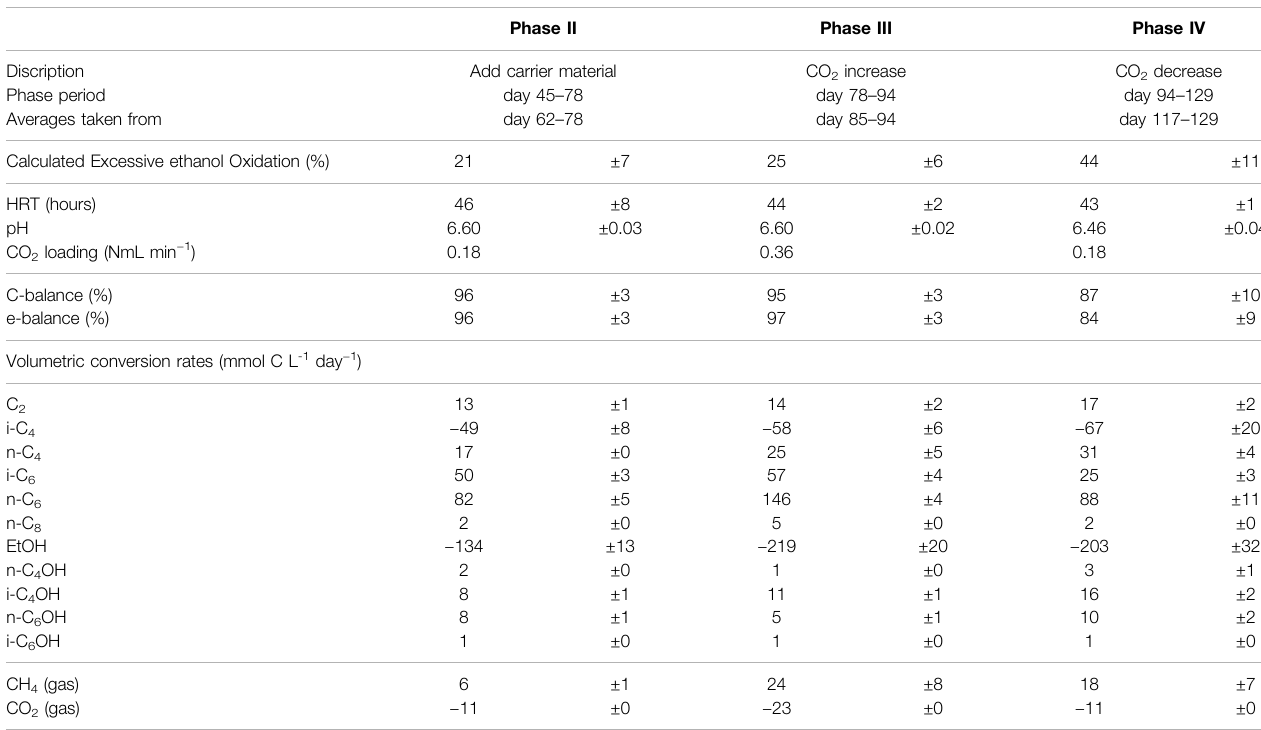
TABLE 5| Overviewofaveragedoperating parameters andconversionratesincluding con fi denceintervals. Averagesfromphase IVaretakenwhencaproate formationhad stabilized (day 106 –